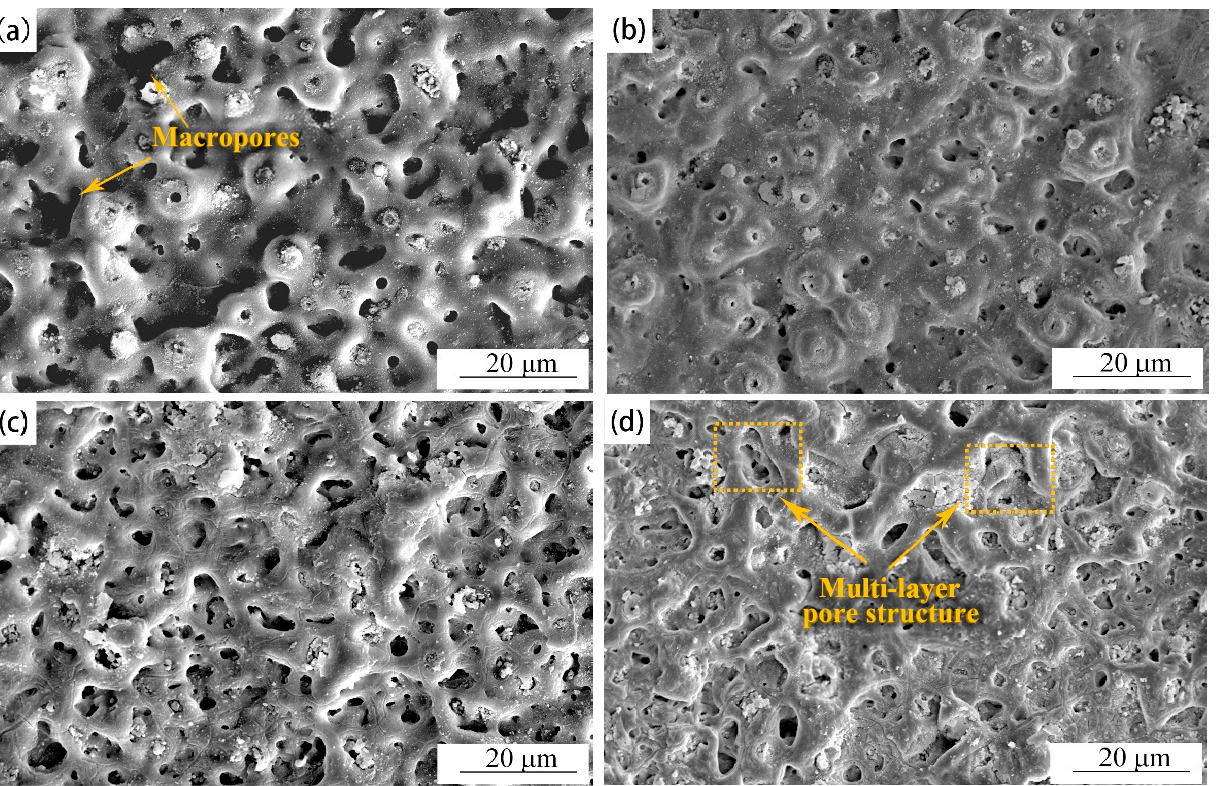
Figure 1. Surface morphologies of MAO coatings with different oxidation times: ( a ) 5 min; ( b ) 10 min; ( c ) 15 min; ( d ) 20 min.